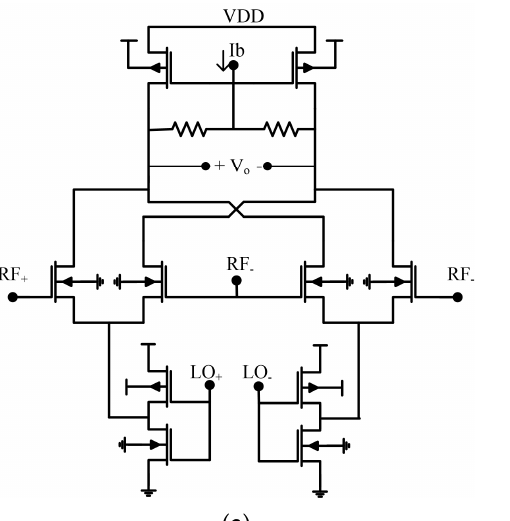
Figure 9. ( a ) Mixer schematic; and ( b ) implemented layout.